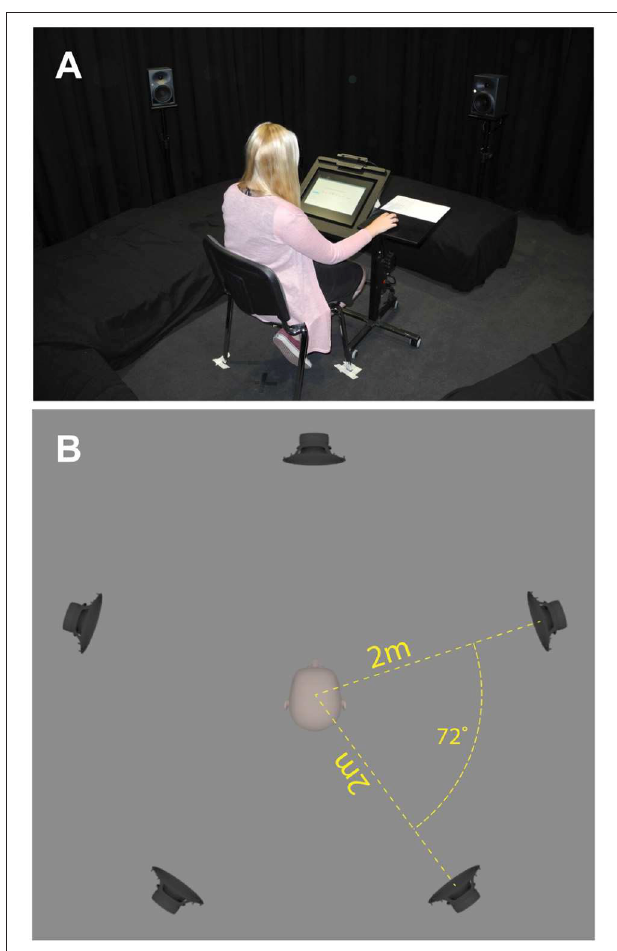
FIGURE 1 | The experimental setup in AuraLab, where the subject was seated in the central listening spot (A,B) . For this experiment, additional porous absorbers were put on the floor (A) . The stimuli were played back through five satellite loudspeakers and two subwoofers (B) .